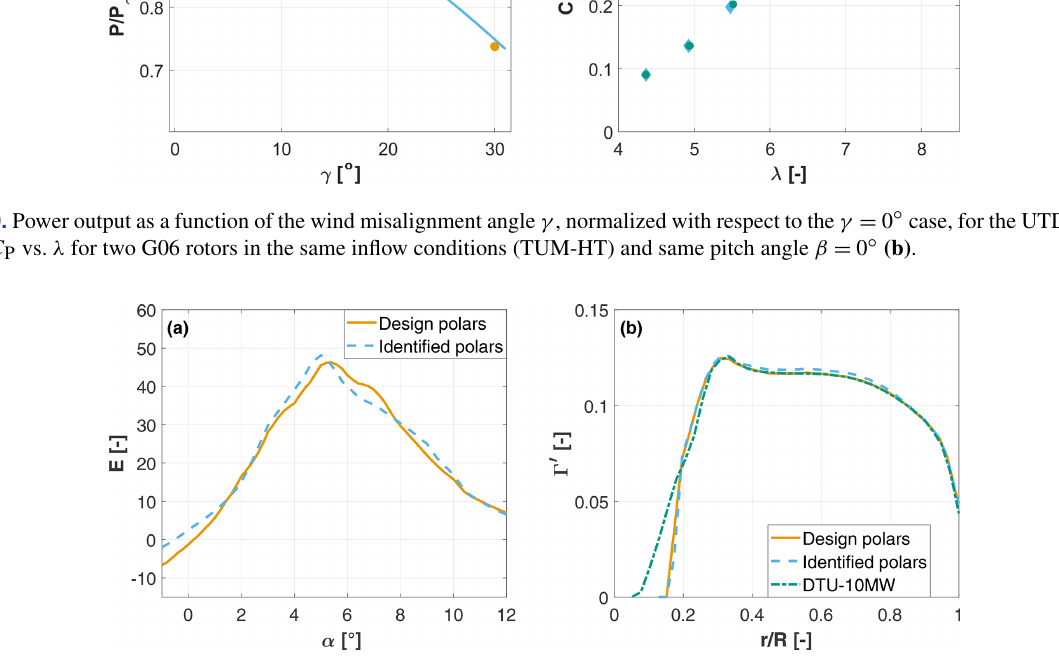
Figure 11. Comparison between airfoil efficiency E calculated with the nominal polars and the identified ones, for a chord-based Reynolds number equal to 70000 (a) . Nondimensional circulation distribution (cid:48) (cid:48) along the blade span r/R for the G06 using the nominal design and the identified polars and for the reference turbine (b)